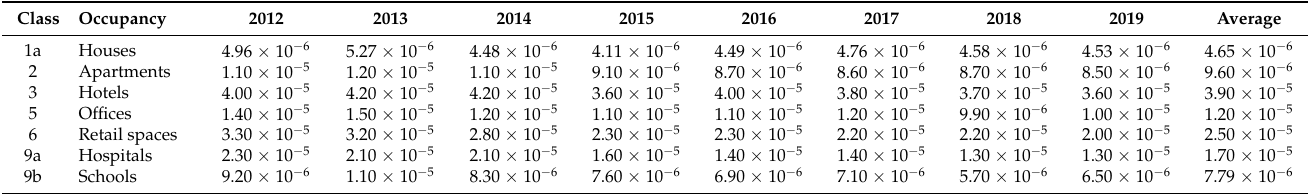
Table 3. Ignition frequency of structural fires for NCC classes in Australia from 2012 to 2019 [fire/m 2 · year] taken from the Australian Bureau of Statistics, the Department of Climate Change and Energy Efficiency, and